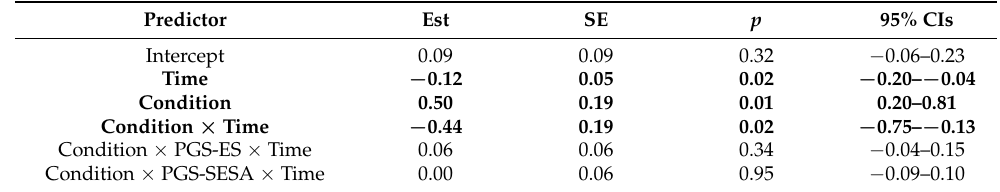
Table 4. Multilevel model statistics testing the intervention effect and moderator effect on HCC.